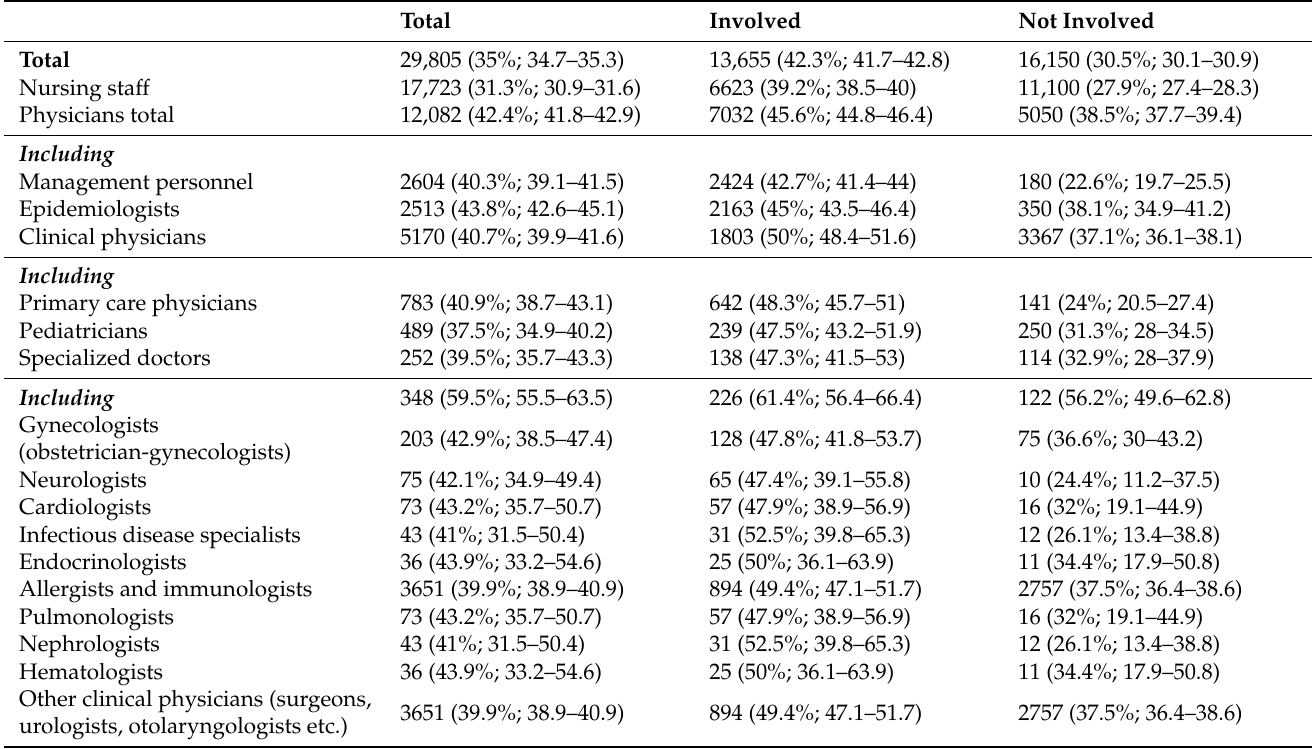
Table A2. Proportion of healthcare workers ready to be vaccinated against COVID-19 (depending on involvement in vaccination process).